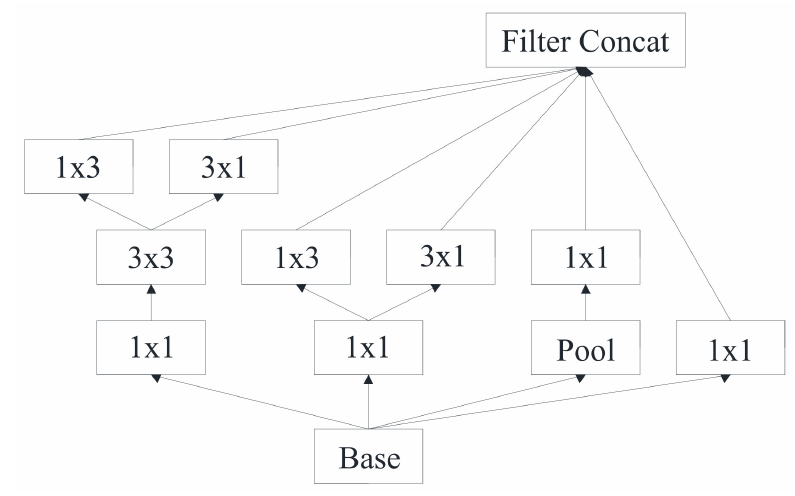
Figure 5. The 2 × Inception module.